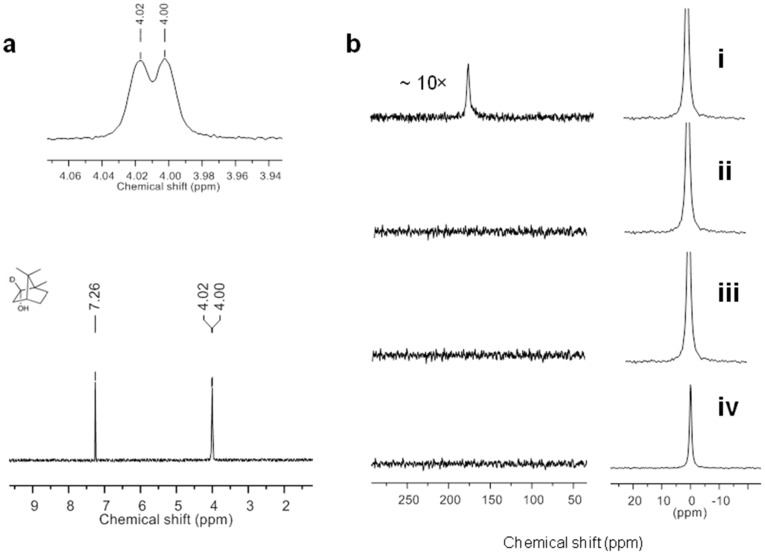

2H NMR of the 2-D-borneol and 17O NMR in the detection of H2
17O2.
a)
2H NMR of the 2-D-borneol obtained from the recombinant proteins incubated in 50 mM deuterated phosphate buffer (pD = 7.4) with camphor and m-CPBA. The extracted product was backwashed with H2O. The peak at 7.26 ppm corresponds to CHCl3 in CDCl3. b)
17O NMR spectrum of the incubation mixture in 17O phosphate buffer (pH 6.3) containing: i) camphor, recombinant P450cam and m-CPBA, ii) camphor and recombinant P450cam (m-CPBA absent), iii) camphor and m-CPBA (enzyme absent), and iv)
m-CPBA and recombinant P450cam (substrate absent). The peaks at 0 ppm and 178 ppm correspond to H2
17O and H2
17O2, respectively.